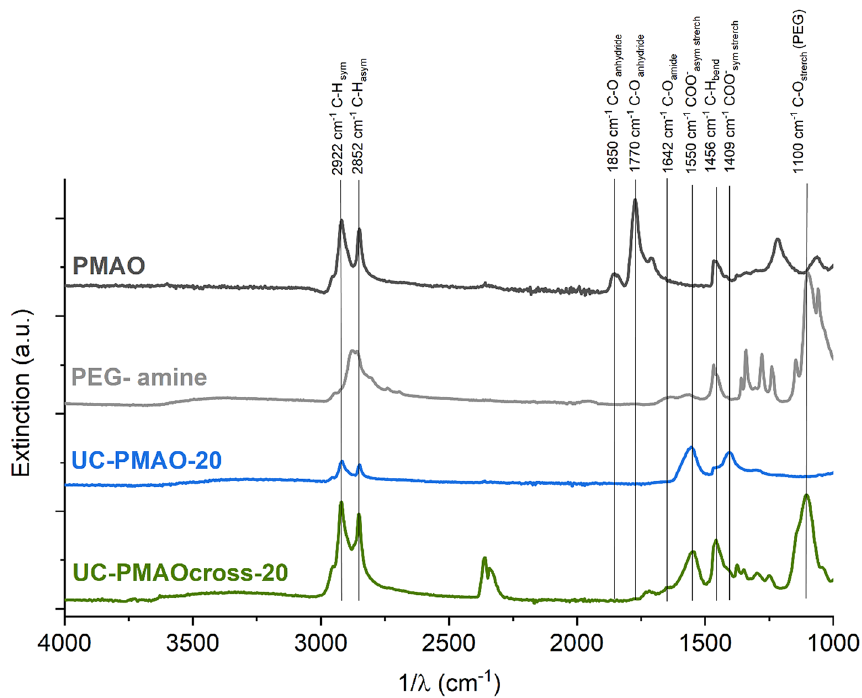
Figure 2. ATR-FTIR spectra of UCNPs with amphiphilic coatings and the corresponding